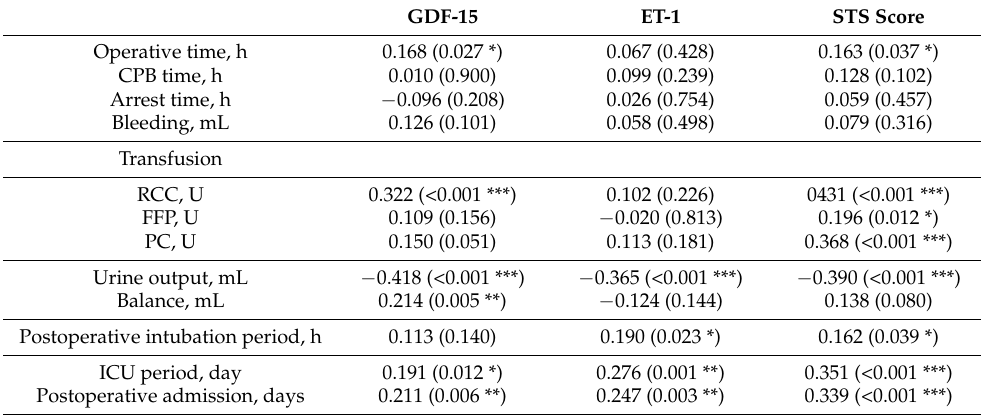
Table 3. Relationships between GDF-15/ET-1/STS score and operative